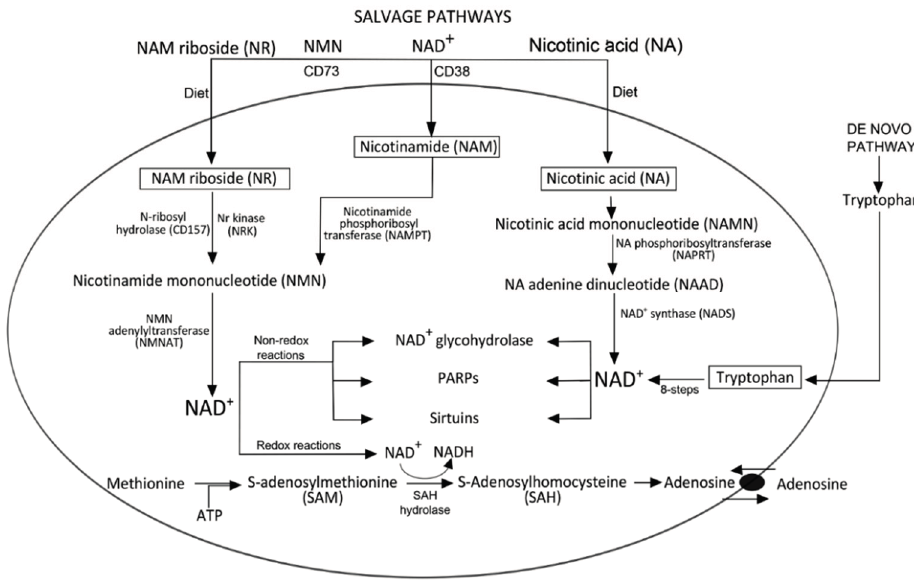
Figure 1. Pathways for NAD + biogenesis and NAD + -consuming enzymes. Cellular NAD